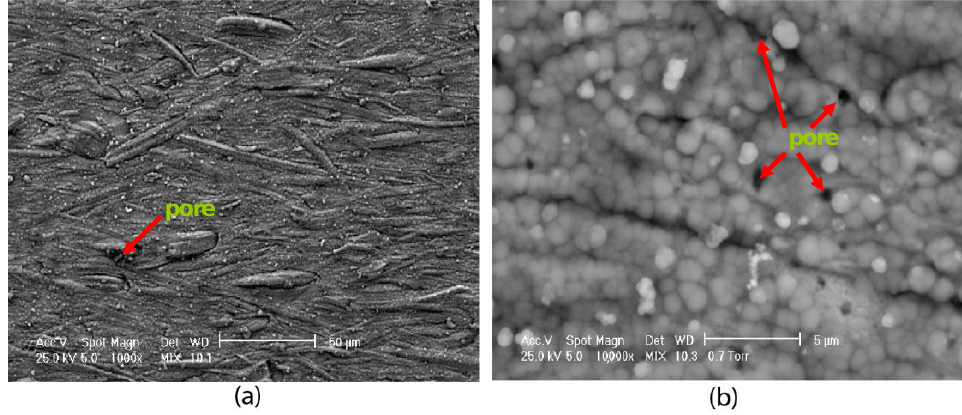
Figure 9. SEM morphology of the equimolar CoCrFeMnNi thin film, sample 1: ( a ) ×1000; ( b ) ×10,000.